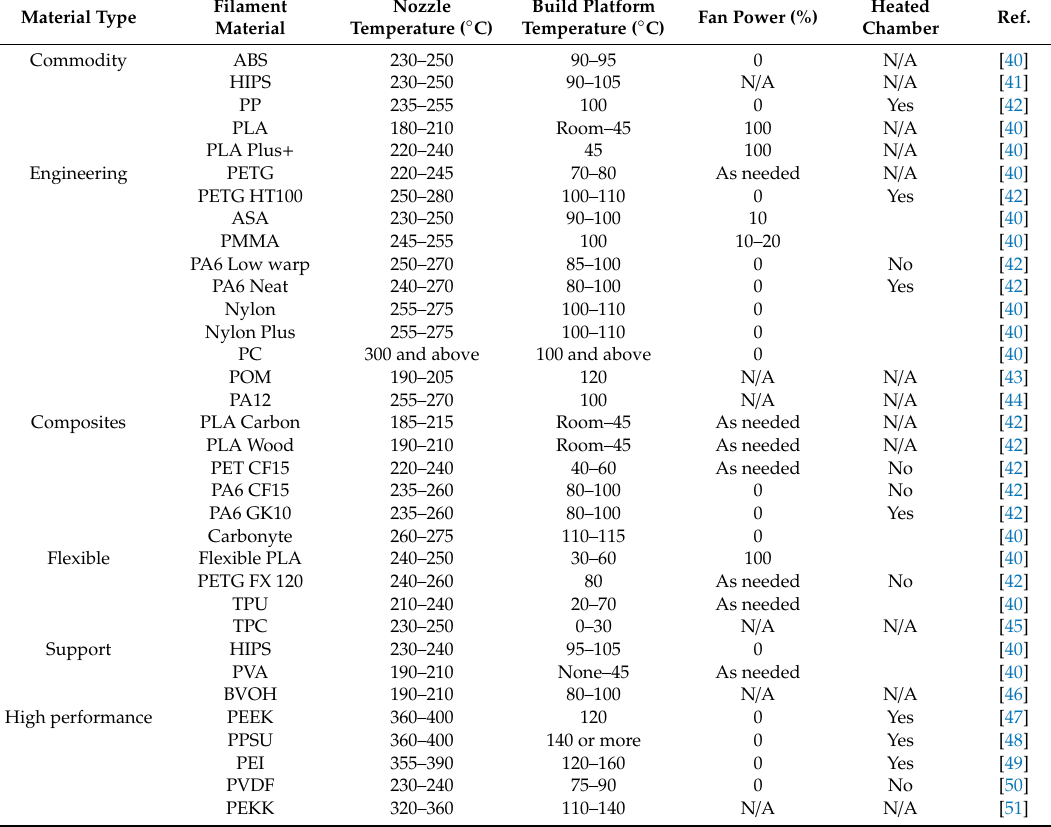
Table 3. Material temperature